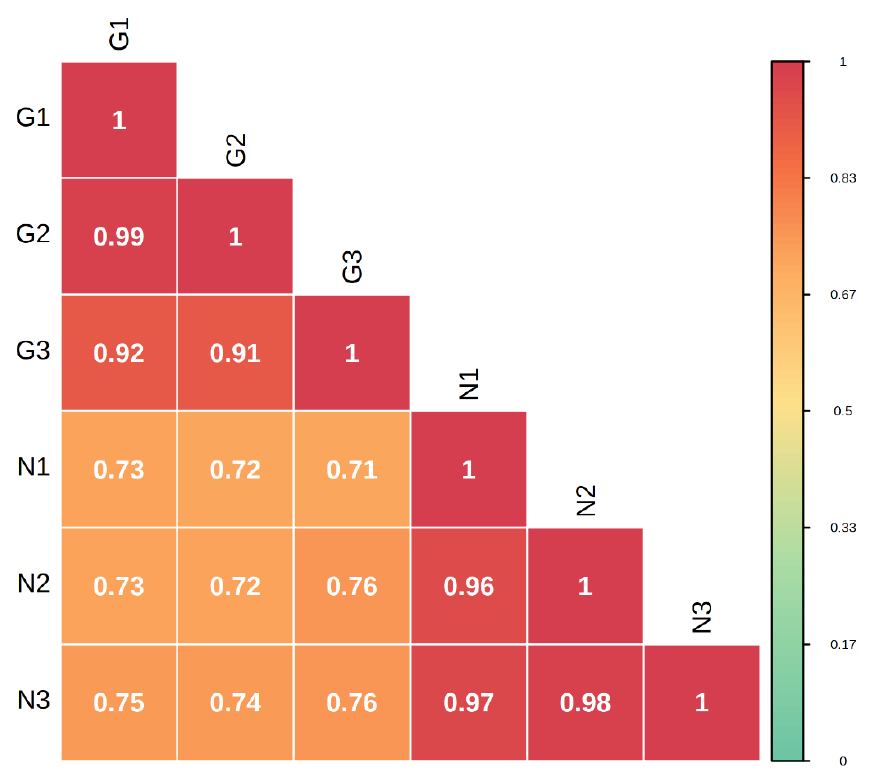
Figure 3. Correlation plot between G type and N type samples.